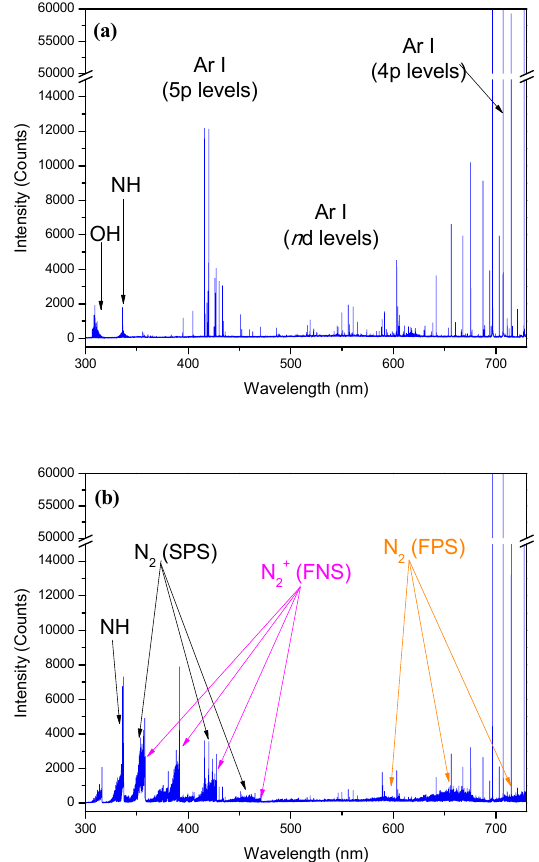
Figure 3. Optical emission spectra of a pure Ar ( a ) and an Ar-N 2 (1% N 2 ) ( b ) plasma .